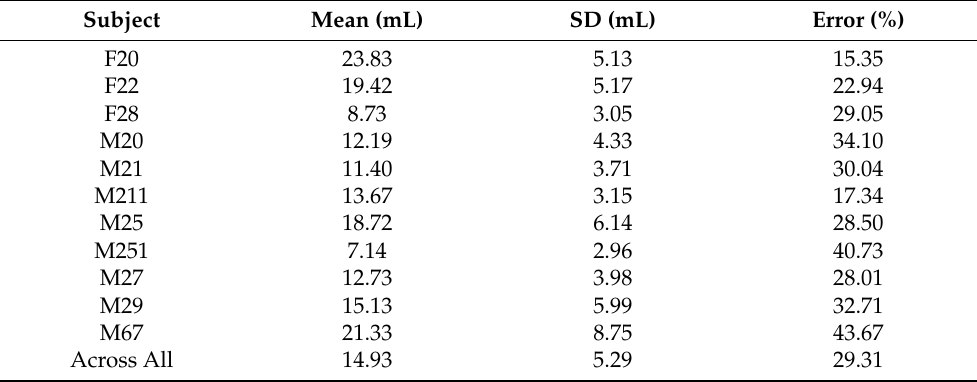
each subject. The last column shows the estimation error when using the mean as the predicted swallowed volume.